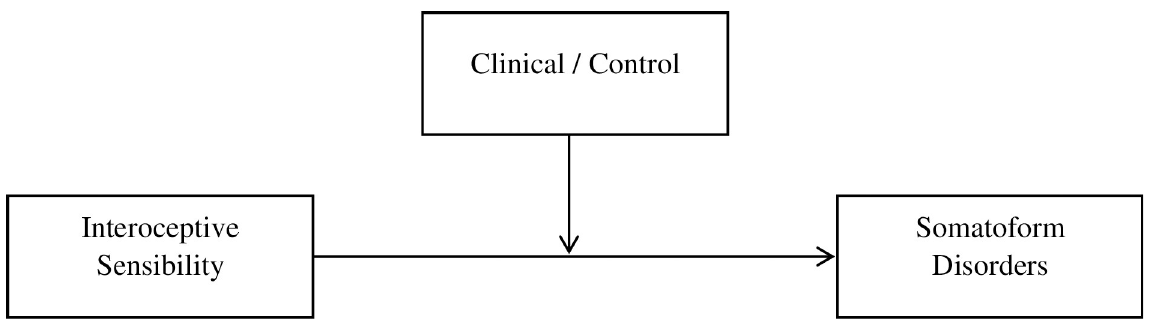
Fig 2. A graphical model presenting the nature of dependencies in moderation model.